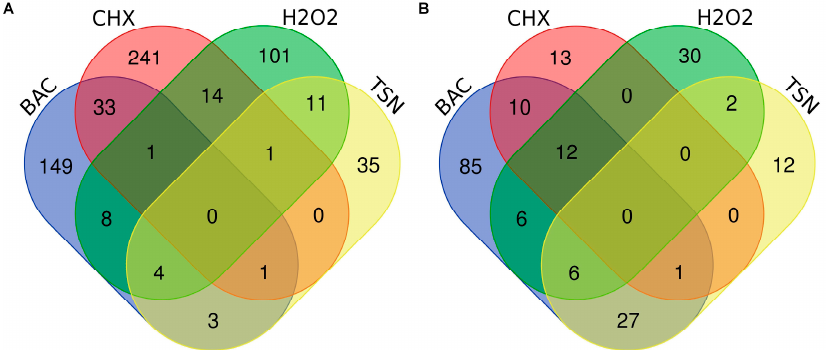
Figure 3. Venn diagrams showing numbers of differentially transcribed genes in response to all four biocides. ( A ) genes with increased transcripts, ( B ) genes with decreased transcripts. All genes with significantly elevated and reduced transcription were included as input, regardless of fold change.